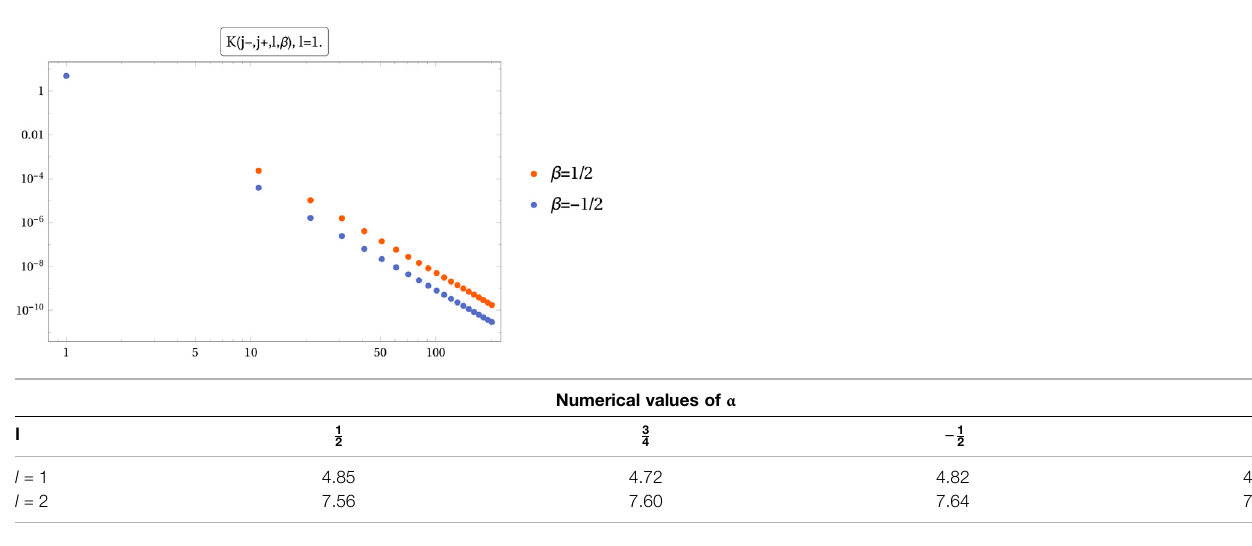
(cid:31)(cid:31)(cid:31)(cid:31) (cid:31)(cid:31)(cid:31)(cid:31) β j + in a logarithmic scale. Bottom panel: computed estimates of the propagator ’ s